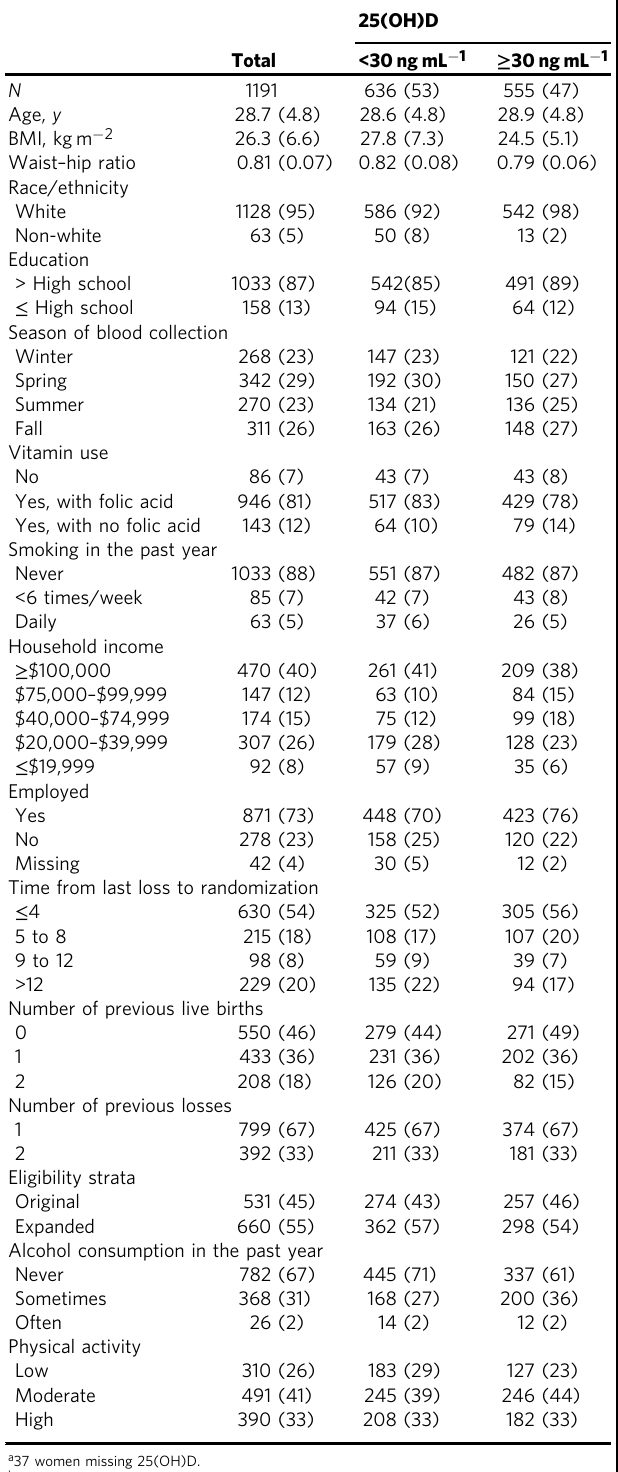
Table 1 Study population characteristics by preconception vitamin D status in the Effects of Aspirin in Gestation and Reproduction (EAGeR) trial, 2007 – 2011 a,b